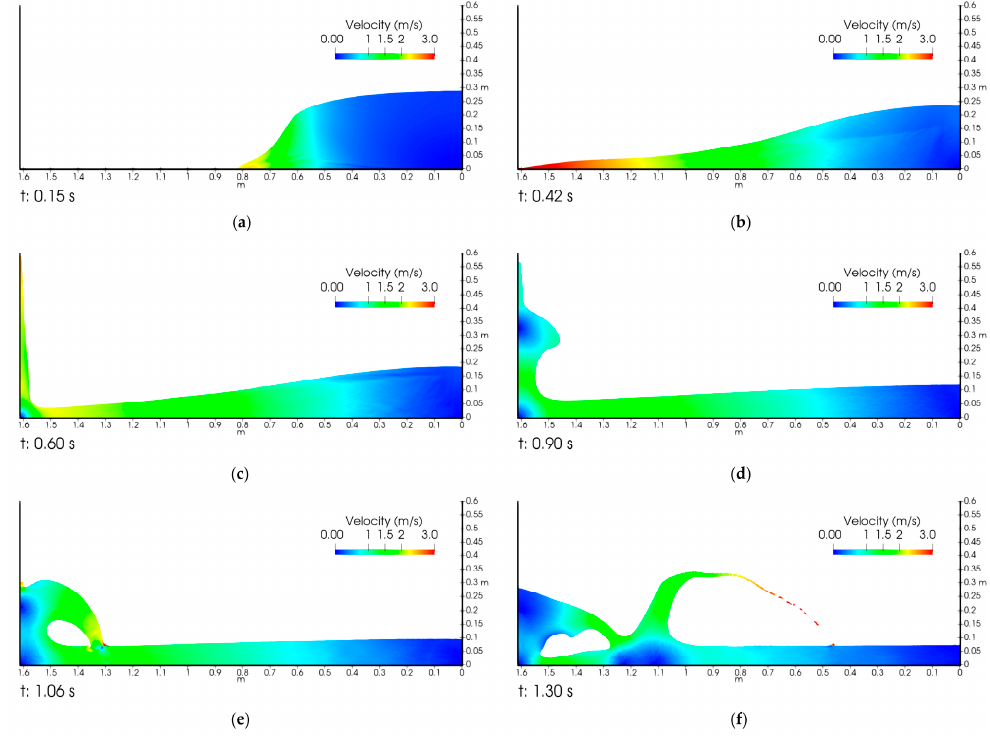
Figure 2. Two-dimensional dam-break phenomena: field snapshots of the absolute value of velocity at several time instants: ( a ) t = 0.15 s; ( b ) t = 0.42 s; ( c ) t = 0.60 s; ( d ) t = 0.90 s; ( e ) t = 1.06 s; and ( f ) t = 1.30 s.